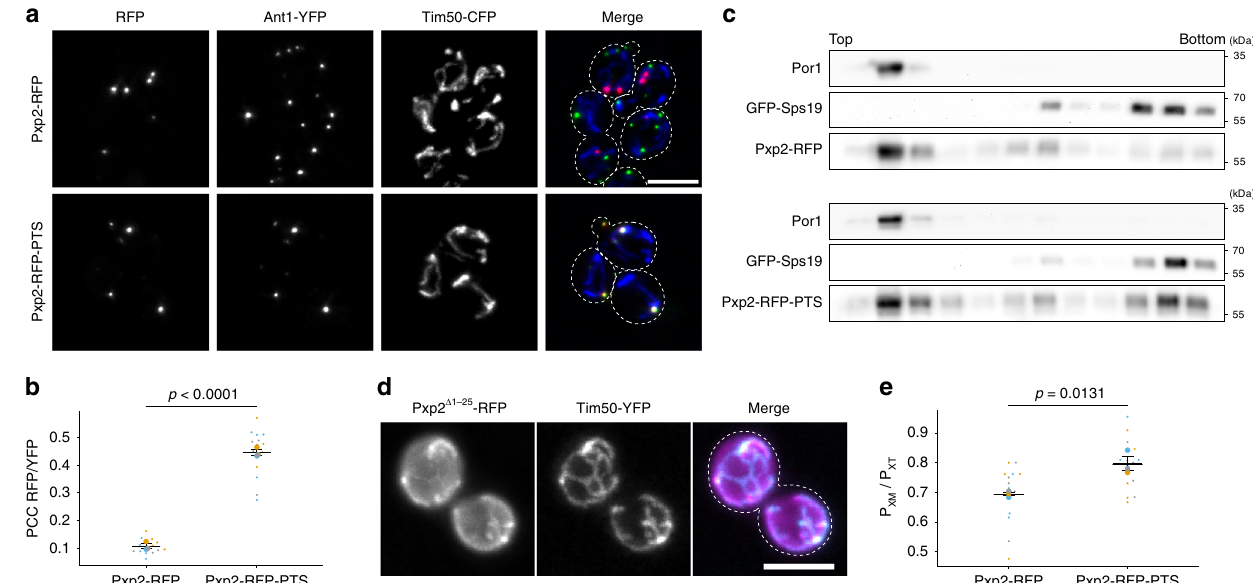
Fig. 6 Dual targeting of Pxp2 to mitochondria and peroxisomes. a Subcellular localization of Pxp2-RFP (red) and Pxp2-RFP-PTS (red) was determined using fl uorescence microscopy. Ant1-YFP (green) and Tim50-CFP (blue) were used to label peroxisomes and mitochondria, respectively. White color represents overlap of all three signals. Scale bar represents 5 µ m. b Correlation of Pxp2-RFP or Pxp2-RFP-PTS with Ant1-YFP was analyzed. PCC refers to Pearson ’ s correlation coef fi cient. Quanti fi cations are based three independent experiments ( n = 3). Each experiment is represented by a different color. Error bars represent standard error of the mean. P -values were calculated with a two-tailed unpaired Student ’ s t -test. c Subcellular localization of Pxp2-RFP and Pxp2-RFP-PTS was determined using density gradient centrifugation. Twelve fractions, collected from the top of the gradient, were analyzed by SDS – PAGE and western blot. d Twenty fi ve amino acids from the N-terminus of Pxp2 were fused to RFP. Pxp2 1 – 25 -RFP (magenta) was expressed in a strain also containing Tim50-YFP (cyan). The resulting strain was analyzed by fl uorescence microscopy. White color indicates colocalization. Scale bar represents 5 µ m. e Quanti fi cation of the fraction of peroxisomes contacting mitochondria (Px M ) in relation to the total peroxisome count (Px T ) of cells co- expressing Pxp2-RFP or Pxp2-RFP-PTS with Ant1-YFP, and the mitochondrial membrane protein Tim50 fused to CFP. Association of Ant1-YFP containing foci with Tim50-CFP was counted. Quanti fi cations are based on three independent experiments ( n = 3). Each experiment is represented by a different color. Error bars represent standard error of the mean. P -values were calculated with a two-tailed unpaired Student ’ s t -test. Source data are provided in the Source data fi